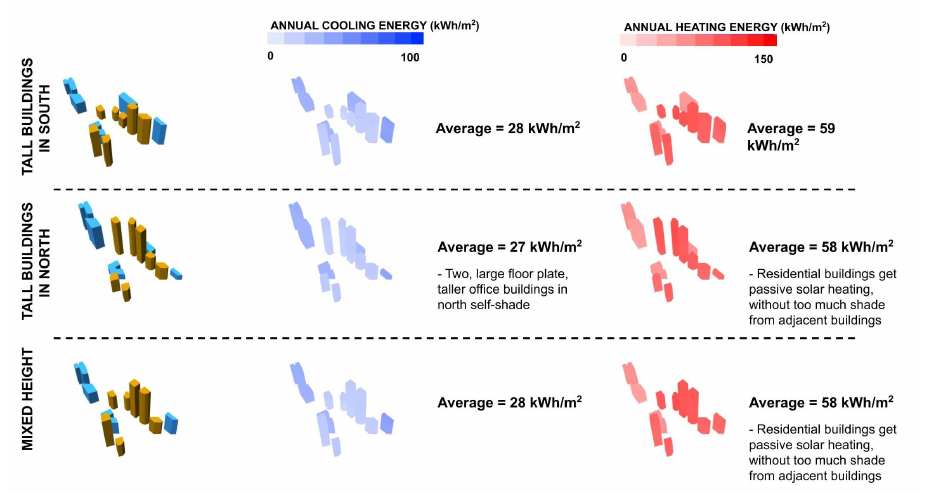
Figure 11. Simulation results from the massing design